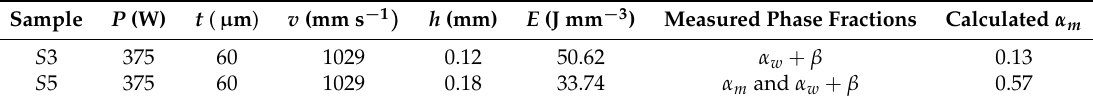
Table 4. Process parameters of the Ti6Al4V cubes S3 and S5 fabricated by SLM in [30] and final phase fraction observed via XRD at the center of the cubes. ( P laser power, t layer thickness, v scanning velocity, h hatch spacing, E energy density).